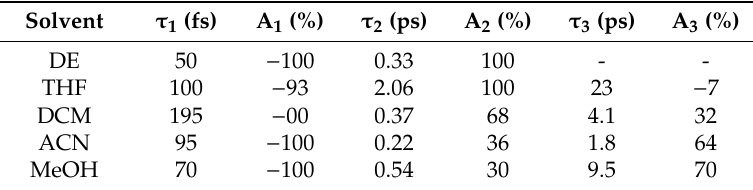
Table 3. Time constants ( τ i ) and normalized (to 100) pre-exponential factors (A i ) extracted from the fits of the femtosecond (fs)-transient absorption decays of Me 2 CANADC excited at 420 nm and probed at 685 nm. A negative value of Ai indicates a rising component in the signal. The estimated error is about